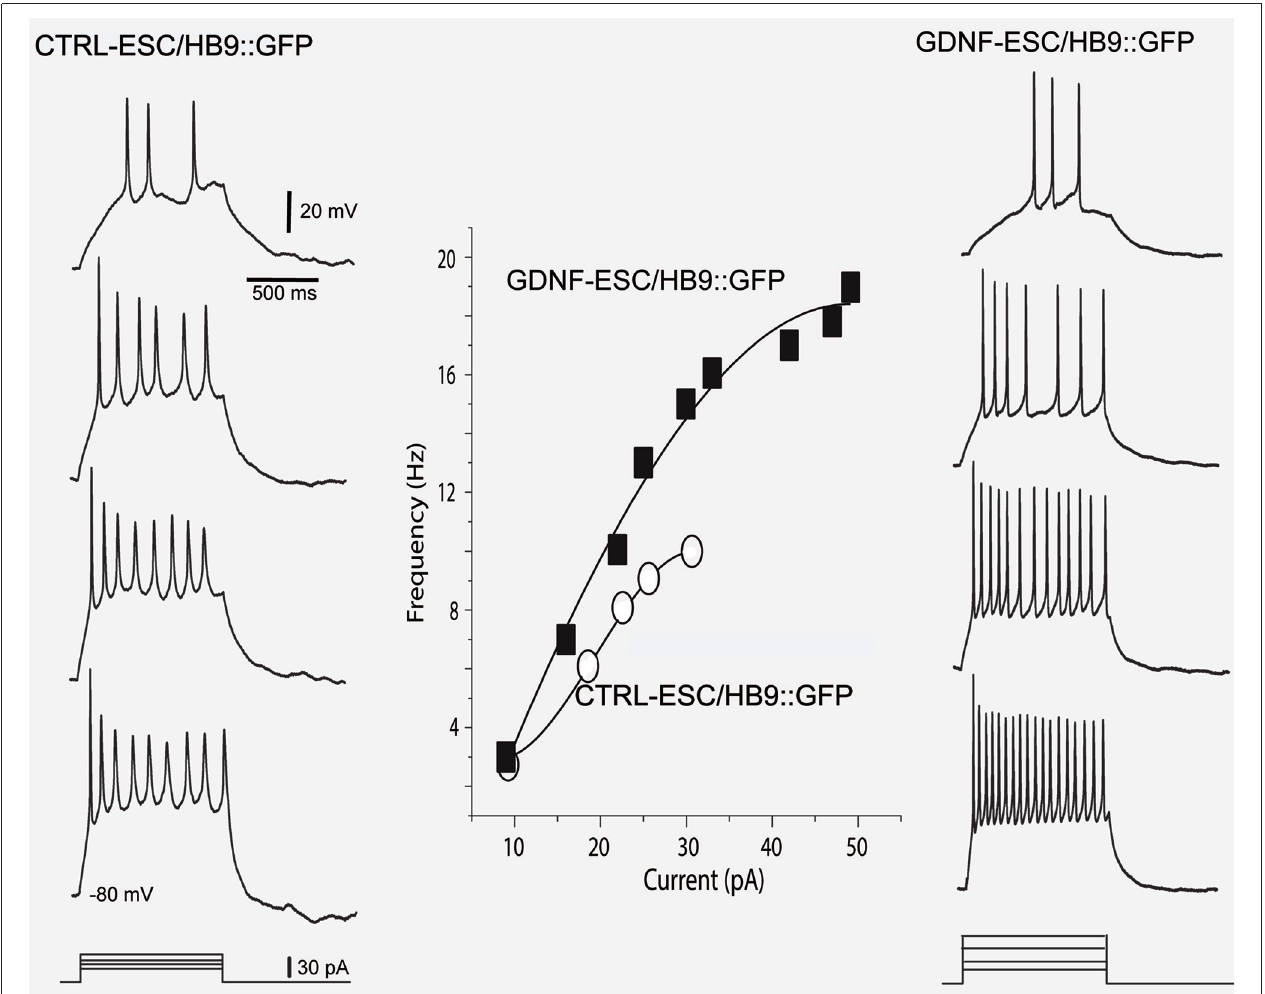
FIGURE 6 | Intensity-frequency plots show increased attained frequency in GDNF-ESC/HB9::GFP motoneurons. Left column , from top to bottom, four representative voltage responses evoked with intracellular current injections of increasing intensity in a Ctrl-ESC/HB9::GFP neuron. Current is represented at the bottom. Frequencies attained are depicted by empty circles at the middle graph. Higher current intensities provoked a halt in firing, due to spike inactivation (not shown). Right column , from top to bottom, four representative voltage responses evoked with increasing intracellular current injections in a neuron producing GDNF (GDNF-ESC/HB9::GFP). Resulting frequencies are depicted by filled squares in the middle graph. Note that frequencies attained are higher in the GDNF-producing cell. Contrary to the observation with the control neuron, higher current intensities could be administered with no signs of spike inactivation in the GDNF-expressing neurons. Multiple treatments were compared with the Kruskal-Wallis analysis of variance (ANOVA) and post hoc Dunn